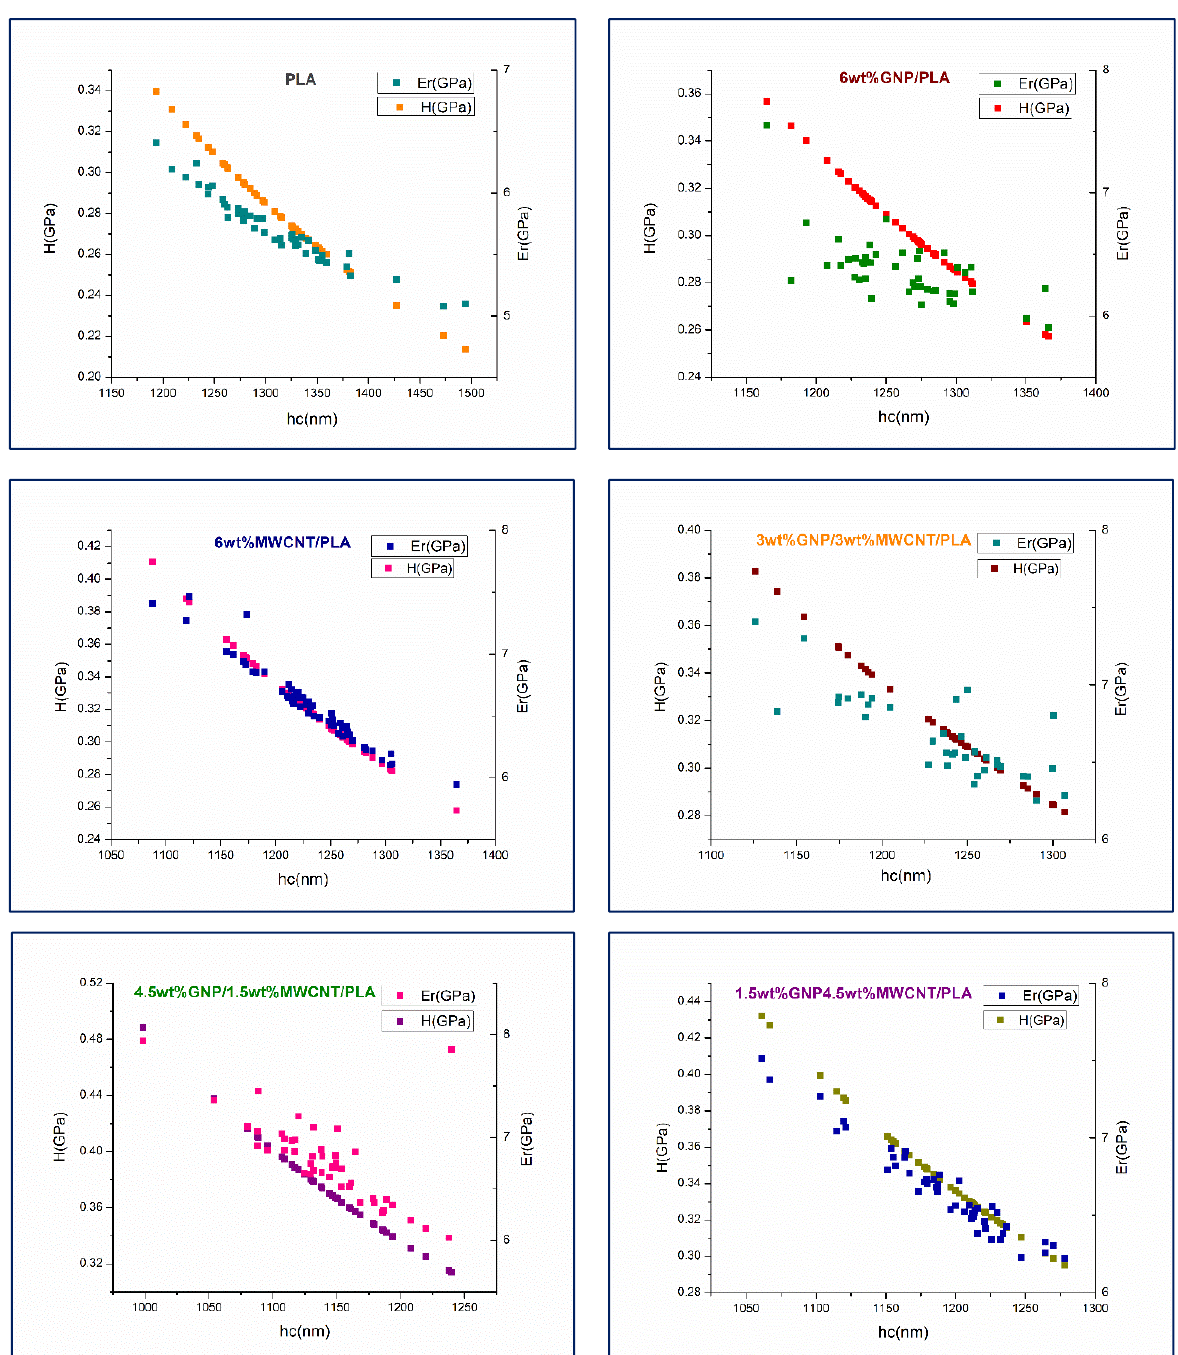
Figure 2. Nanoindentation hardness ( H ) and reduced elastic modulus ( Er ) of two monofiller and three bifiller composite specimens including neat PLA as a reference.